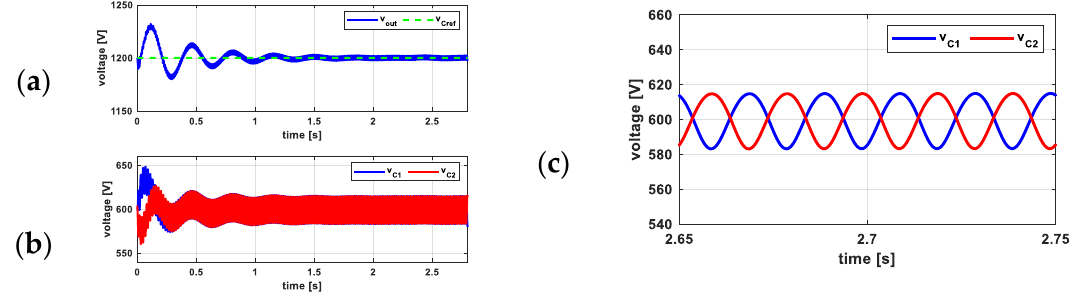
Figure 6. Time behavior of DC-link voltage: ( a ) total DC-link voltage; ( b ) separate DC-link voltage at each capacitor; ( c ) zoom view of separate DC-link voltage at each capacitor.